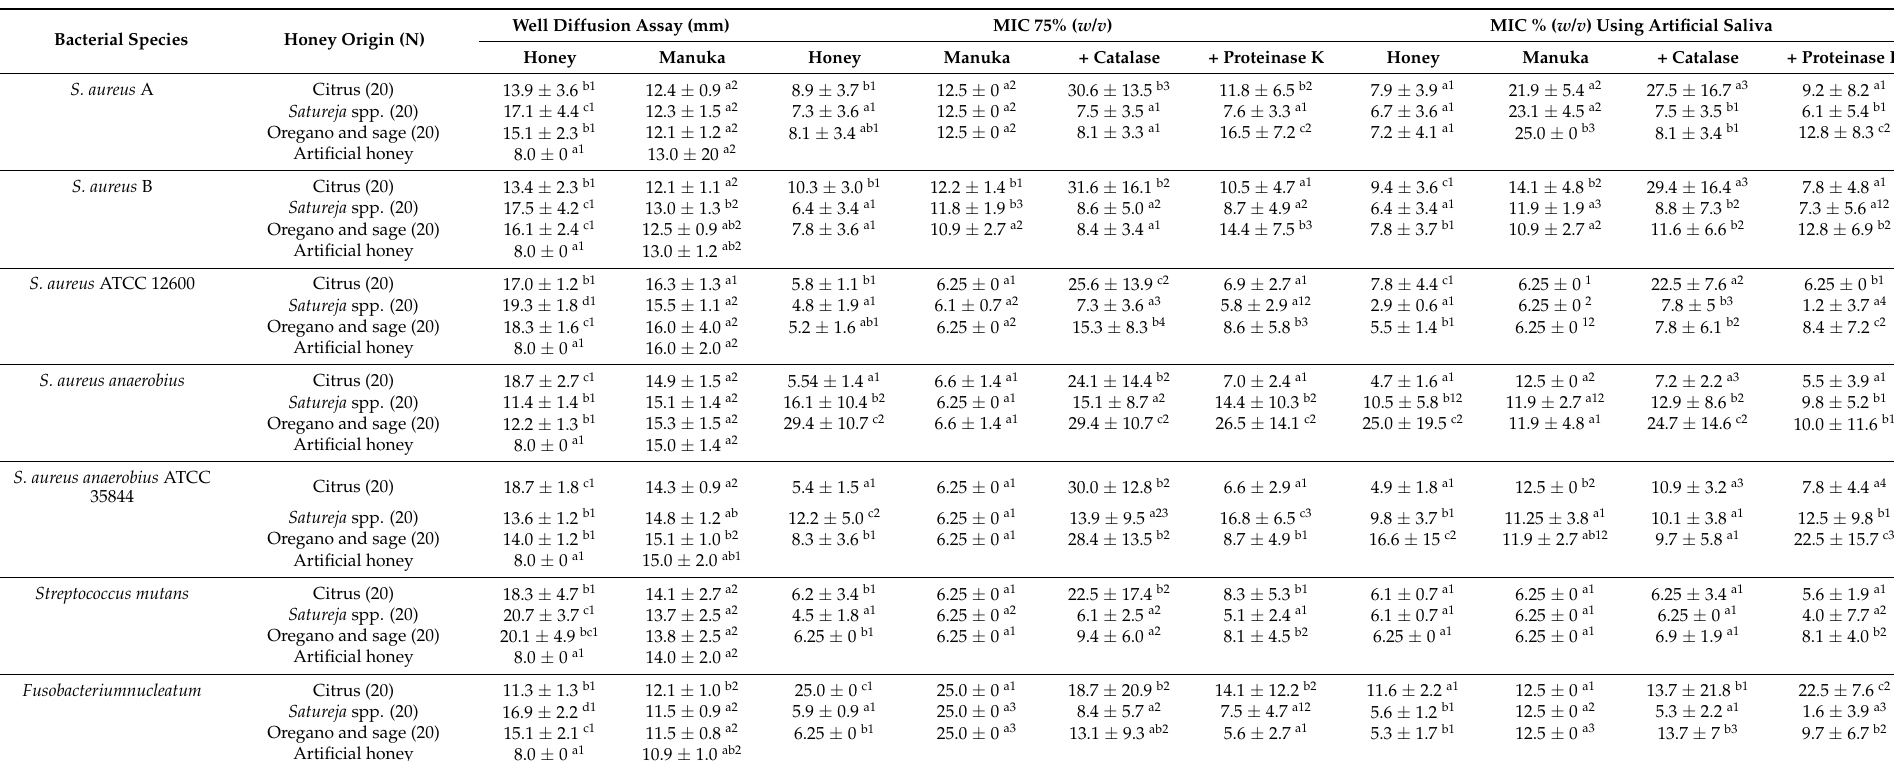
Table 9. Antimicrobial activity of honeys: Minimum inhibitory concentration (MIC) expressed in % w / v by broth dilution and inhibition diameter (mm) including well (8.0 mm) of honeys at 75% by well diffusion assays (WDA) against various